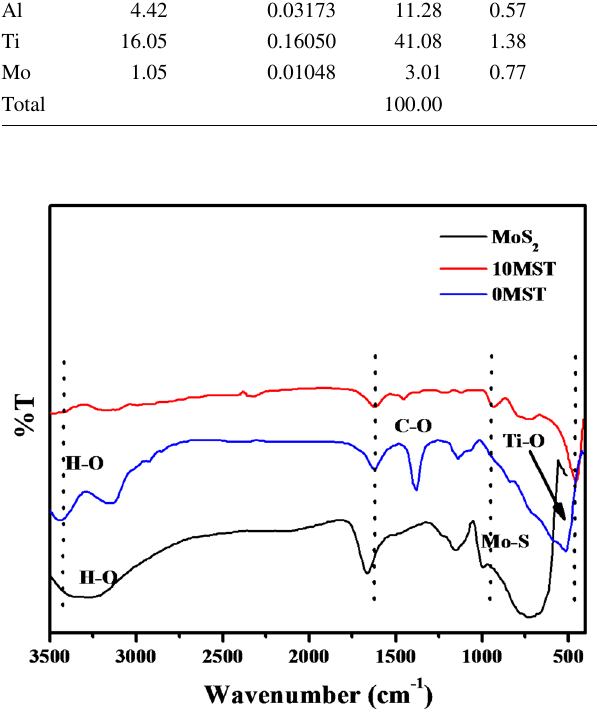
Fig. 5 FT-IR spectroscopy studies of 10 MST sample